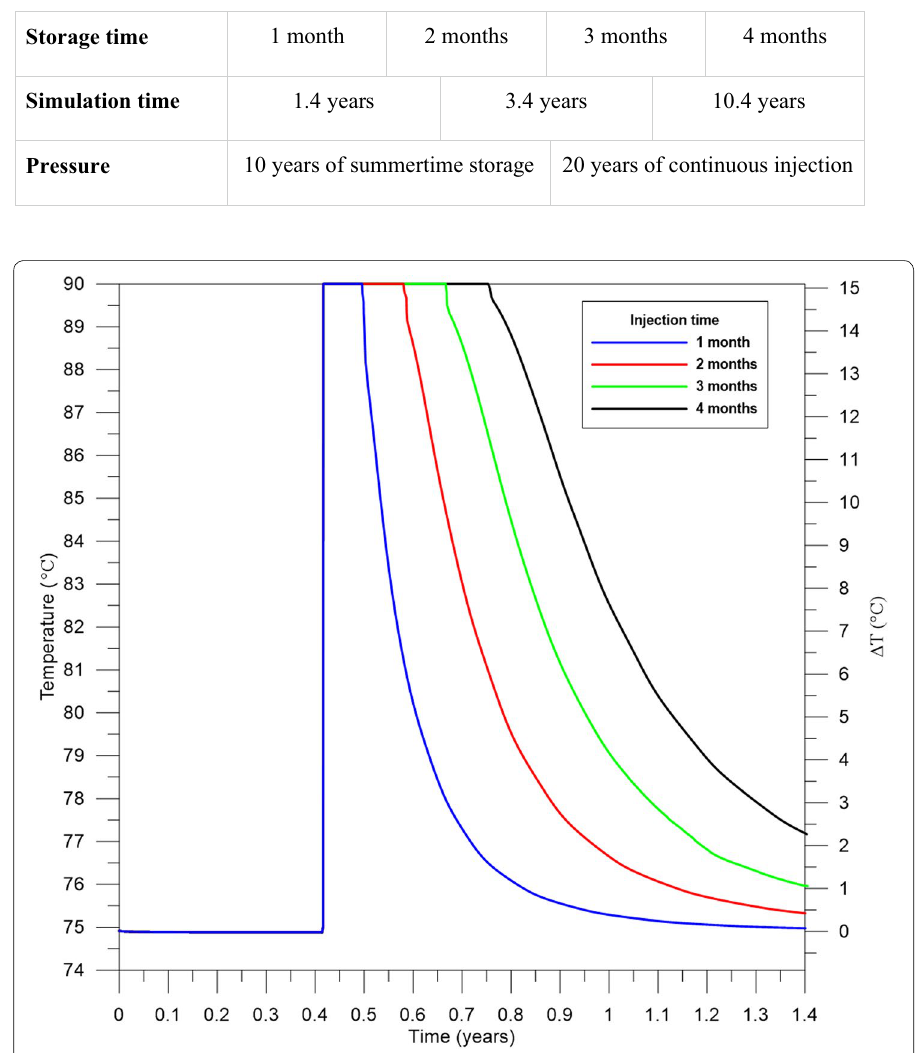
Table 2 Summary of time frame values used for storage simulations